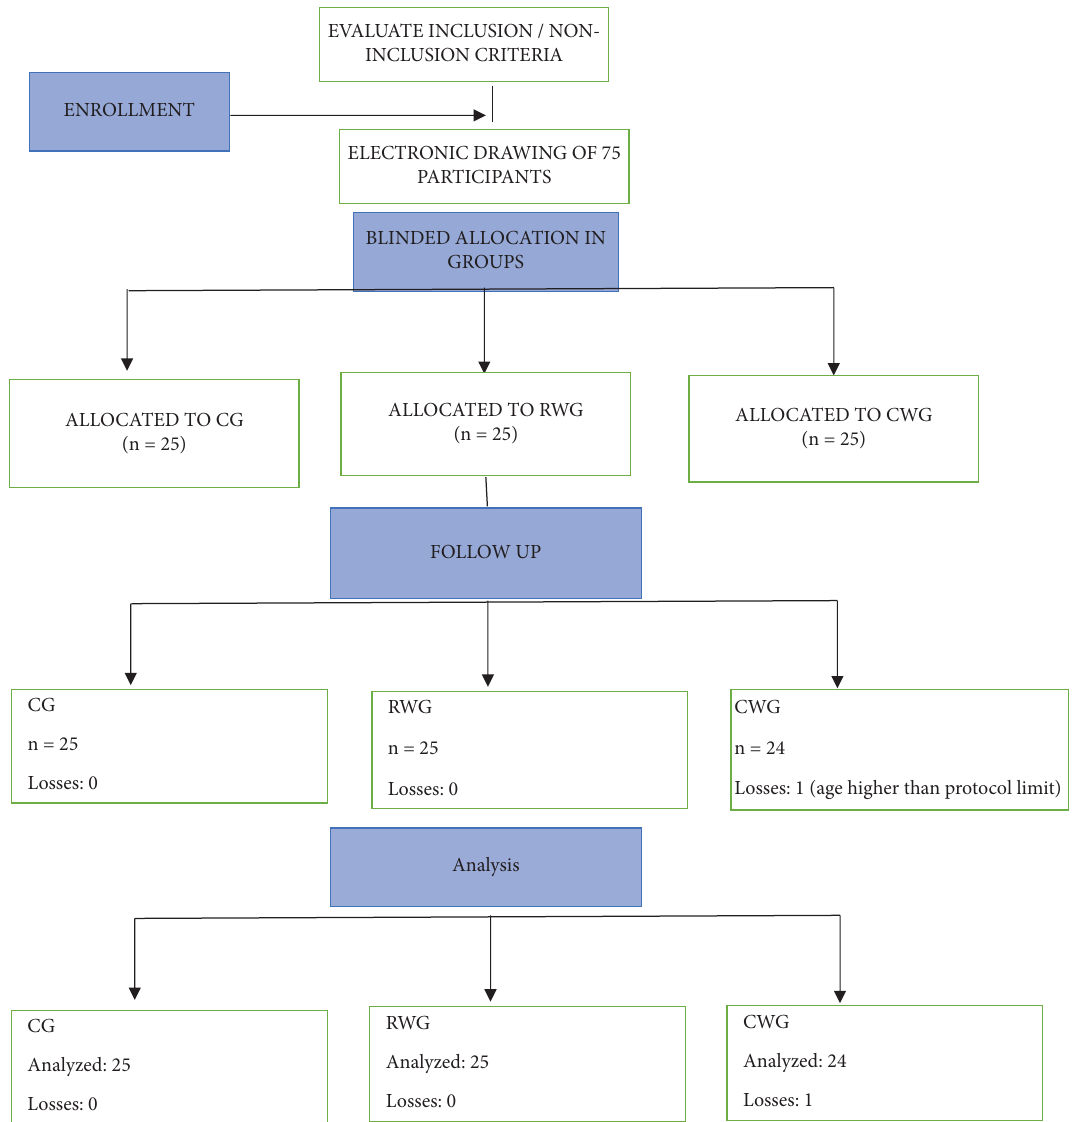
Figure 1: CONSORT Flowchart. CG, control group; RWG, real body weight group; CWG, corrected ideal body weight group. Table 1: Demographic data and duration of